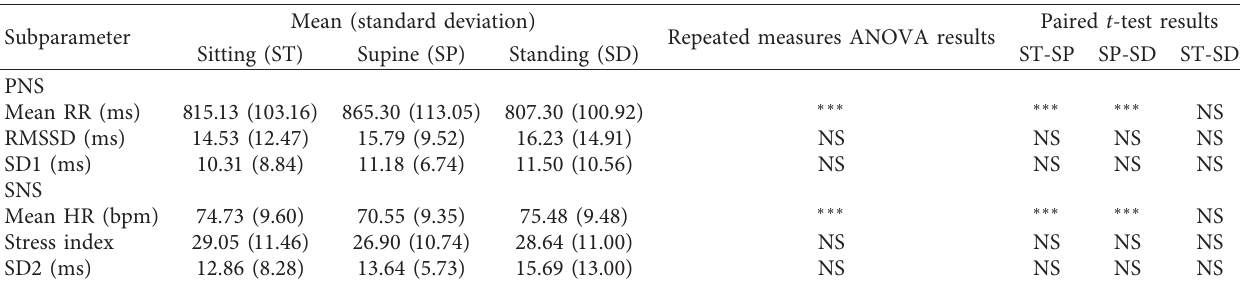
Table 3: Descriptive statistics, repeated measures ANOVA, and paired t -test for PNS and SNS